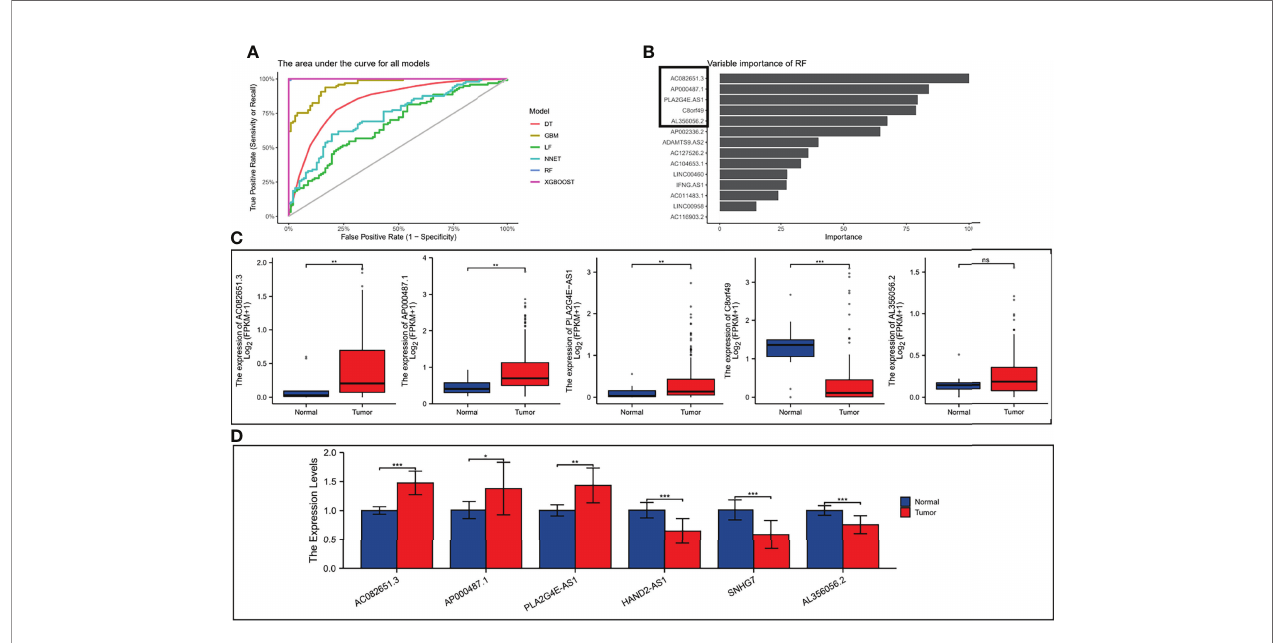
FIGURE 10 | Validation the expression level of ER-lncRNAs. (A) The area under the curve for all models. (B) Top fi ve importance of ER-lncRNAs in RF models. (C) The differential expression of AC082651.3, AP000487.1, PLA2G4E-AS1, C8orf49 and AL356056.2 in ESCC samples compared to adjacent normal controls in TCGA and GTEx RNA-seq data. (D) The expression levels of the 6 ER-lncRNAs in 10 pairs ESCC and matched adjacent normal tissues were examined by qRT- PCR. ns, not signi fi cant, * P < 0.05, ** P < 0.01, *** P <